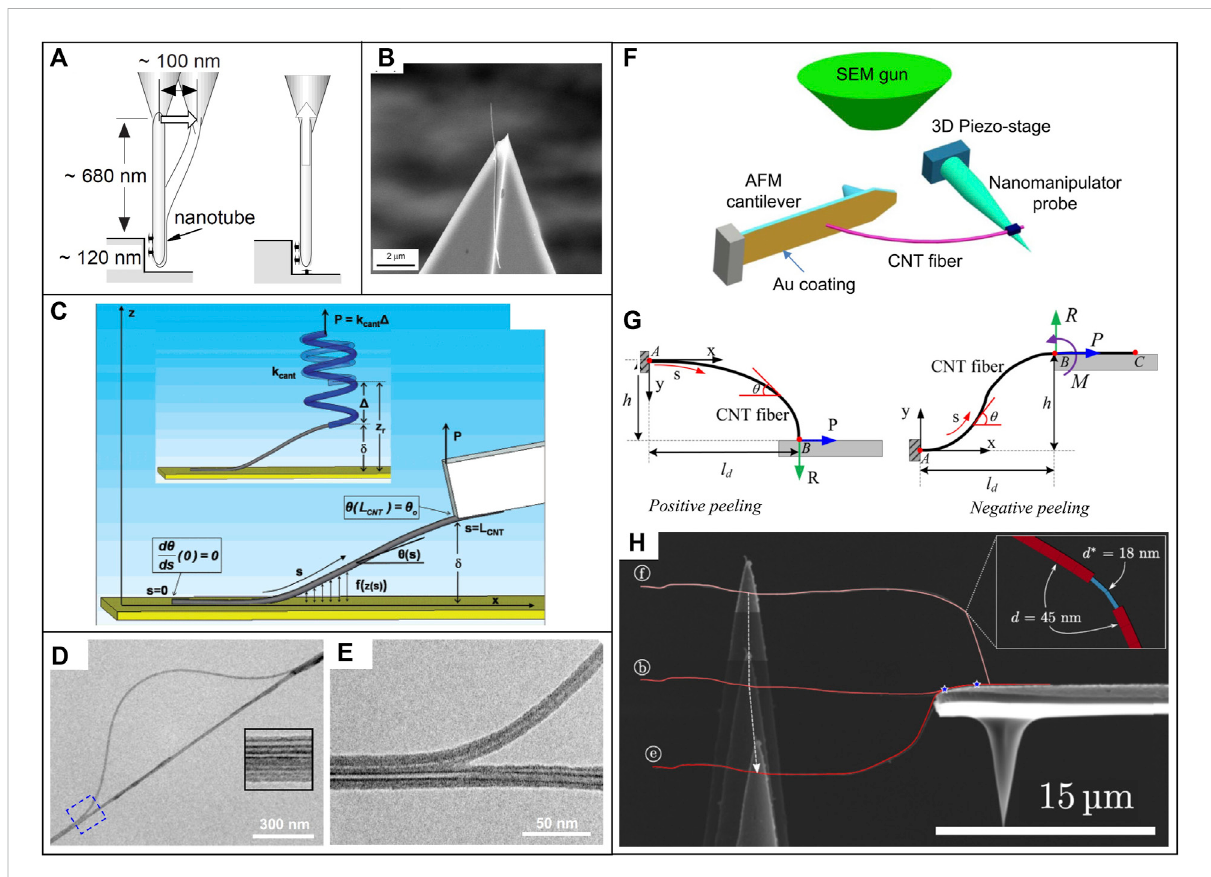
FIGURE 6 (A) Diagram of microcantilever tip decorated with CNT tip for enhanced surface topography scanning using AFM (Akita et al., 2000) (B) SEM micrograph of CNT deposited on the end of a microcantilever tip (Bhushan et al., 2008a). (C) Diagram of parallel-aligned CNT on tipless microcantilever for conducting peeling studies (Strus et al., 2008). (D,E) TEM micrograph observation of the buckled de fl ection shape of partially delaminated CNT bundle (Ke et al., 2010a). (D) Overview of buckled arch, and (E) high-resolution micrograph of delamination region. (F – H)